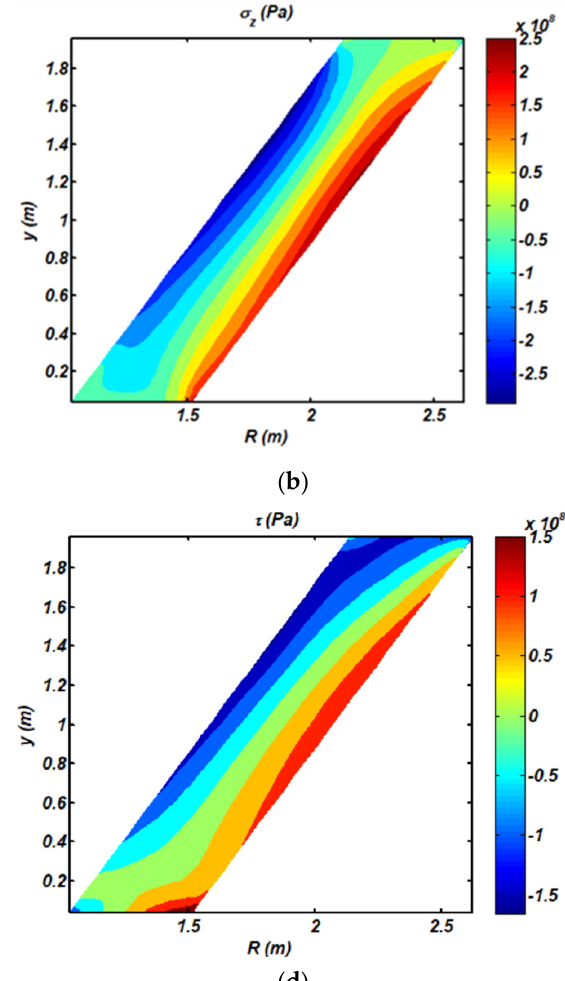
Figure 12. Contour of steady stress state ( a – d ) (D2-GPL V; φ = 30 ◦ ; γ GPL = 0.01; ω = 100 rad/s).